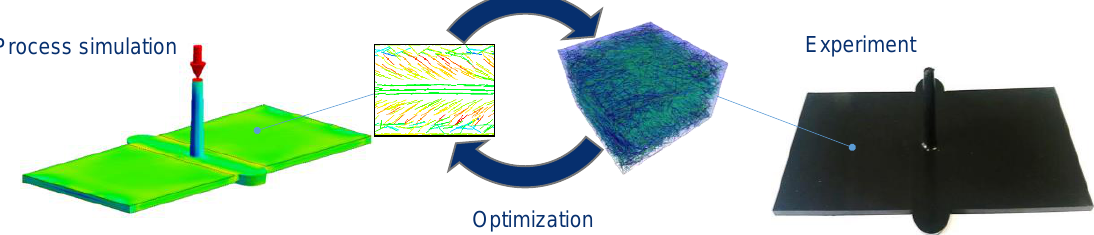
Figure 10. Reverse engineering of fiber microstructure properties at a specific position.